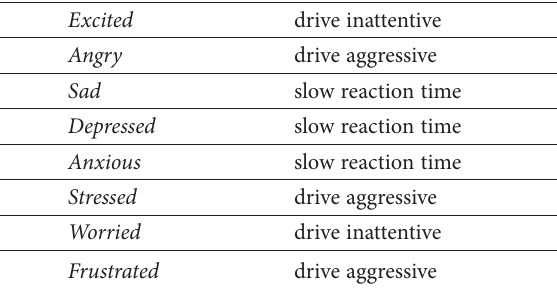
Table. Effects of driving emotionally aroused on the driving task. Strong emotions, both positive and negative, can affect drivers and how they use reduced risk driving decisions, adapted from OPI